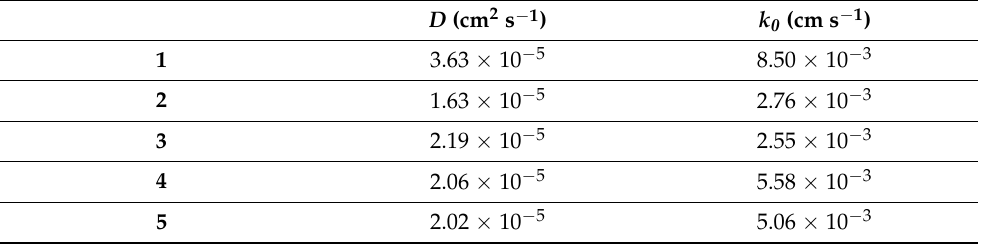
Table 2. Diffusion coefficients ( D ) and heterogeneous electron transfer rate constants ( k 0 ) of tetrazines.